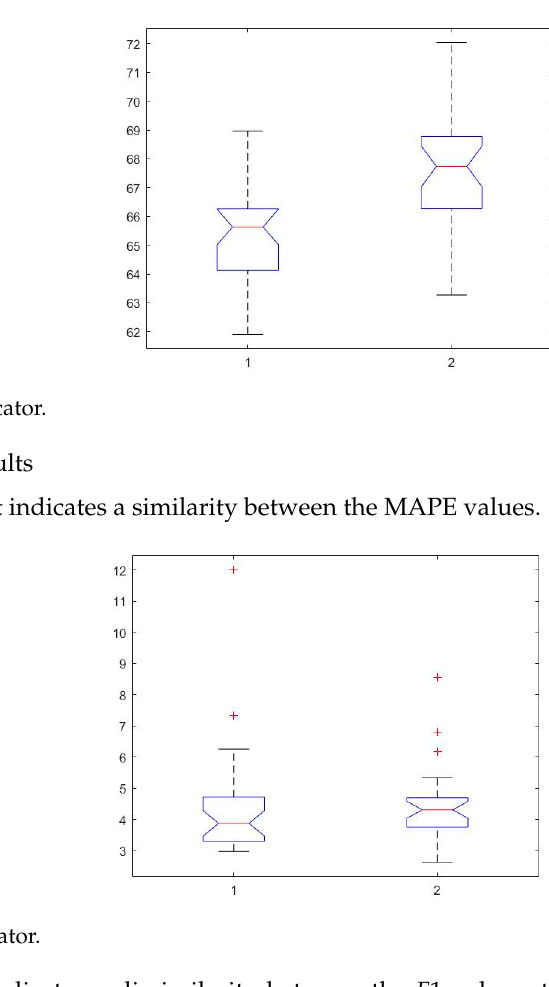
2. F 1 indicator. The result indicates a dissimilarity between the F 1 values, the one corresponding to the proposed method being significantly better.